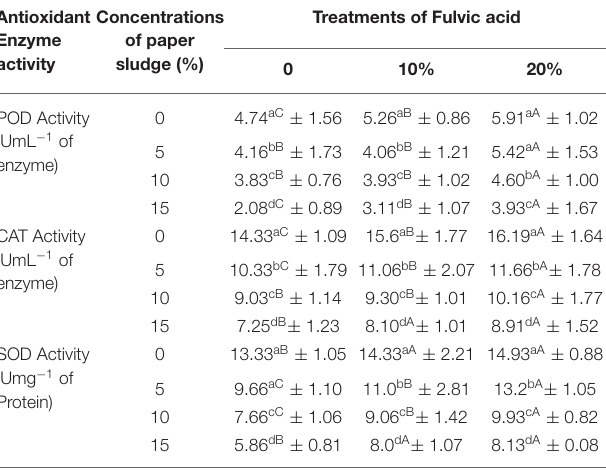
TABLE 3 | Determination of antioxidant enzyme of Brassica napus L. plants grown at different concentrations of paper sludge after 90 days of the experiment. Antioxidant Enzyme